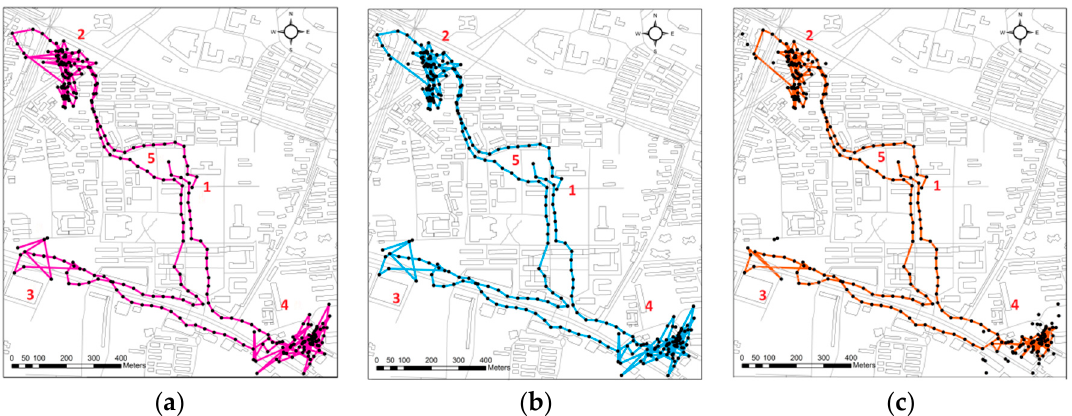
Figure 5. A volunteer walking trajectory, black points are the raw data. ( a ) Original trajectory; ( b ) “Cleaned” trajectory by VA1 + KSC method; ( c ) “Cleaned” trajectory by TRDM method.